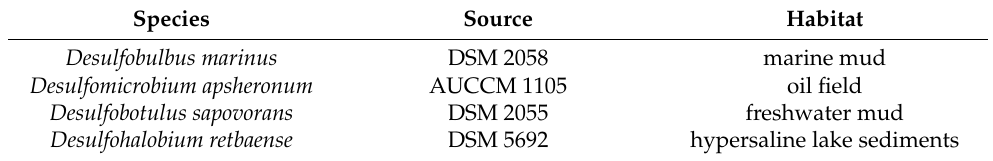
Table 2. Habitats of selected mesophilic sulfate-reducing bacteria (SRB) (modified from Faque [10]). Species Source